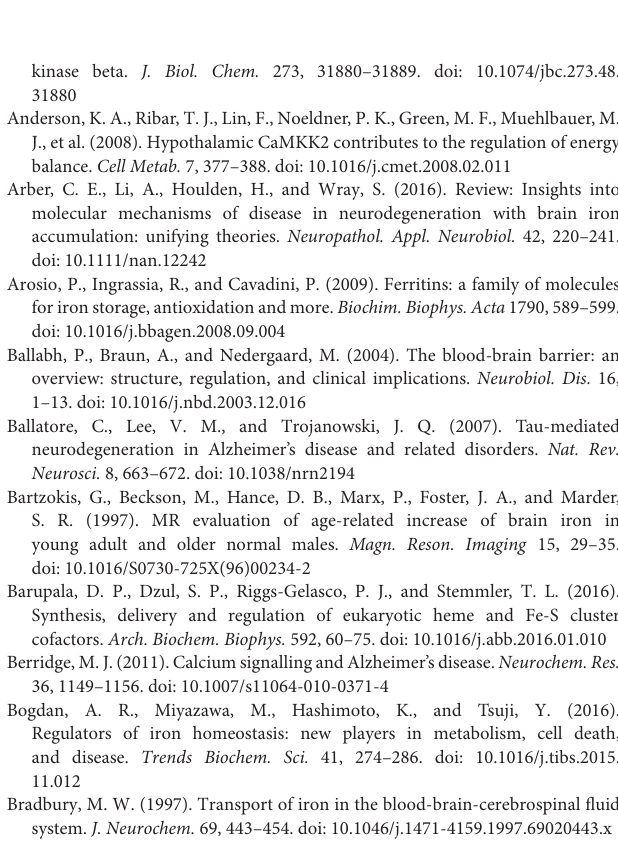
Supplementary Figure 4 | TF model showing surface accessibility of identified P-TF residues and overlapping with kinase motifs. (A) Molecular surface representation of the overall structure of Fe N Fe C -hTF with subdomains N1 in blue, N2 in green, C1 in yellow, C2 in red, and peptide linker in brown (based on PDB:3QYT). Molecular graphics were prepared using UCSF Chimera package (Pettersen et al., 2004). (B) Ribbon and molecular surface representation of hTF showing TFR binding site (Wally et al., 2006) (pink) and potential PDK1 binding motif (orange). (C) Molecular surface presentations of hTF showing TFR binding site and potential PDK1 binding motif as accessible. (D) List of protein motifs predicted for TF (SwissProt entry P02787) using the Scansite cell signaling interactions prediction “MotifScan” module (https://myhits.isb-sib.ch/cgi-bin/ motif_scan) using medium stringency (Obenauer et al., 2003). Supplementary Figure 5 | Human transcriptome and proteome data mining revealed TF and CaMKK2 has overlapping expression pattern in human brain and liver tissues. (A,B) Whisker plot showing CaMKK2 and TF RNA expression in different tissues. The expression values are shown in TPM (transcripts per million) calculated from a gene model with isoforms collapsed to a single gene. (C) Bar graph showing the number of RNA sequencing samples for different tissues used in generating the datasets presented in (A,B) . The data was obtained from the Genotype-Tissue Expression Project (GTEx Portal) on Dec/14/2017. RNA sequencing of coding RNAs data accessed from Genotype-Tissue Expression (GTEx) Project data portal (https://gtexportal.org/home/) ( Fagerberg et al., 2014). Supplementary Figure 6 | Human Protein Atlas data mining showing expression of CaMKK2 and TF in human brain and liver tissues by immunohistochemistry. (A,B) Immunostained section of human cerebral cortex and liver tissues showing strong CaMKK2 expression in neuronal cells and medium CaMKK2 expression was noted in hepatocytes. Polyclonal affinity isolated rabbit anti-CaMKK2 and anti-TF antibodies (catalog number: HPA017389 and HPA001527, respectively, Sigma) were used for immunodetection. Image credit: Human Protein Atlas. Images are available at Human Protein Atlas website version 18